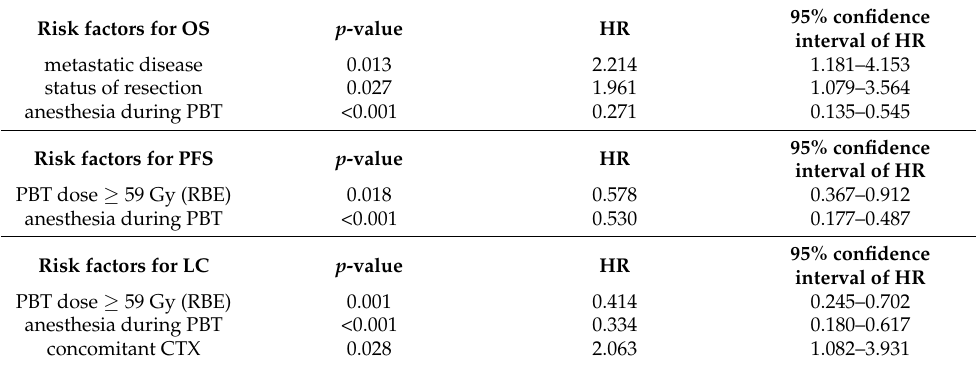
Table 4. Multivariable analysis of risk factors for OS, PFS, and